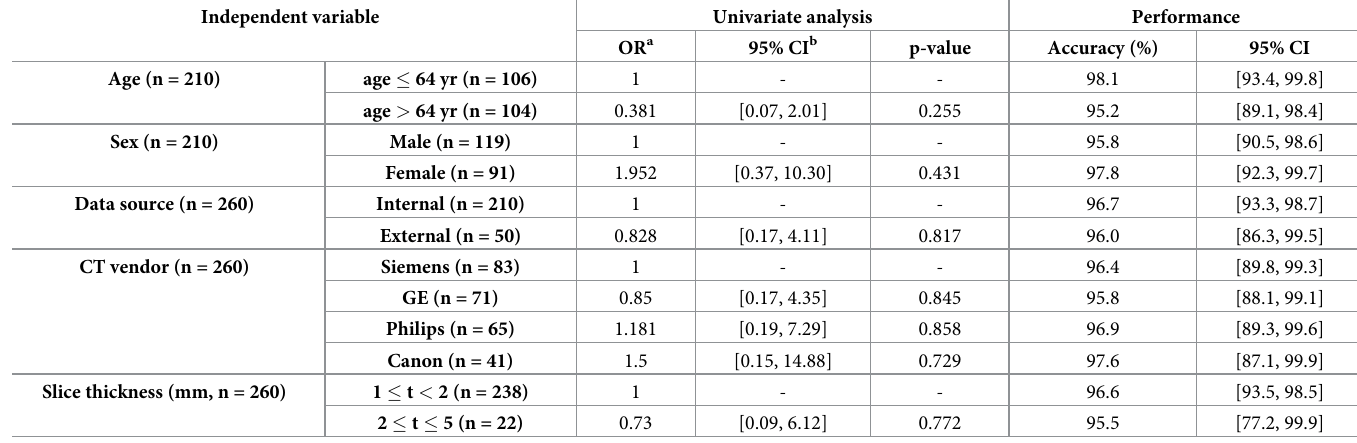
Table 3. Univariate logistic regression analysis. The internal and external data were rearranged to satisfy pre-defined univariate condition for each variable. Independent